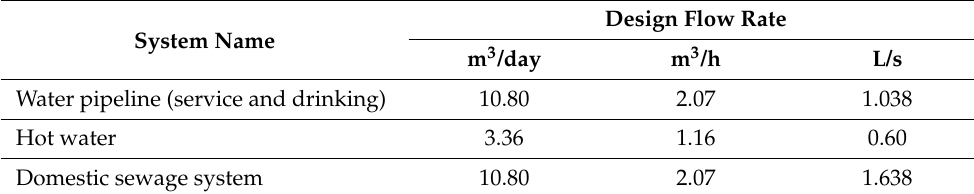
Table 7. Water supply and sewerage system flow